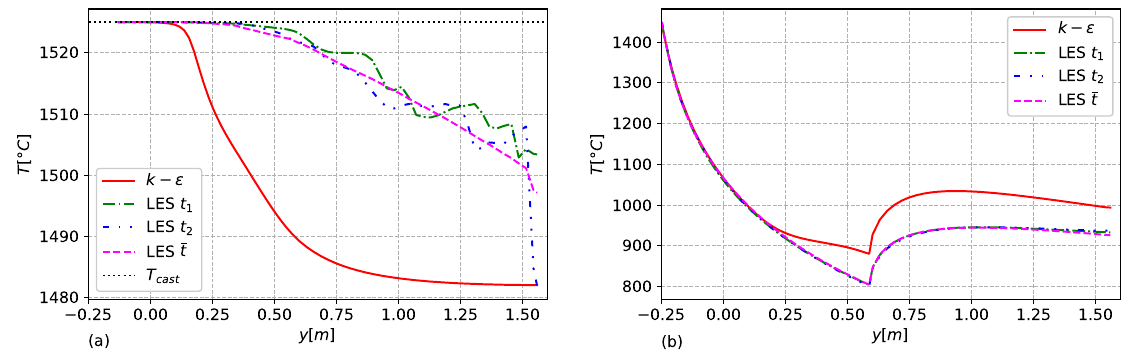
Figure 8. Temperature field. ( a ) At VL1; ( b ) At VL2. Figure 9 shows the temperature field area cross-section at VA3. As in the VA2 cross- section, the steady-state solution of the k − ε model results in lower temperatures in the center of the billet and around the